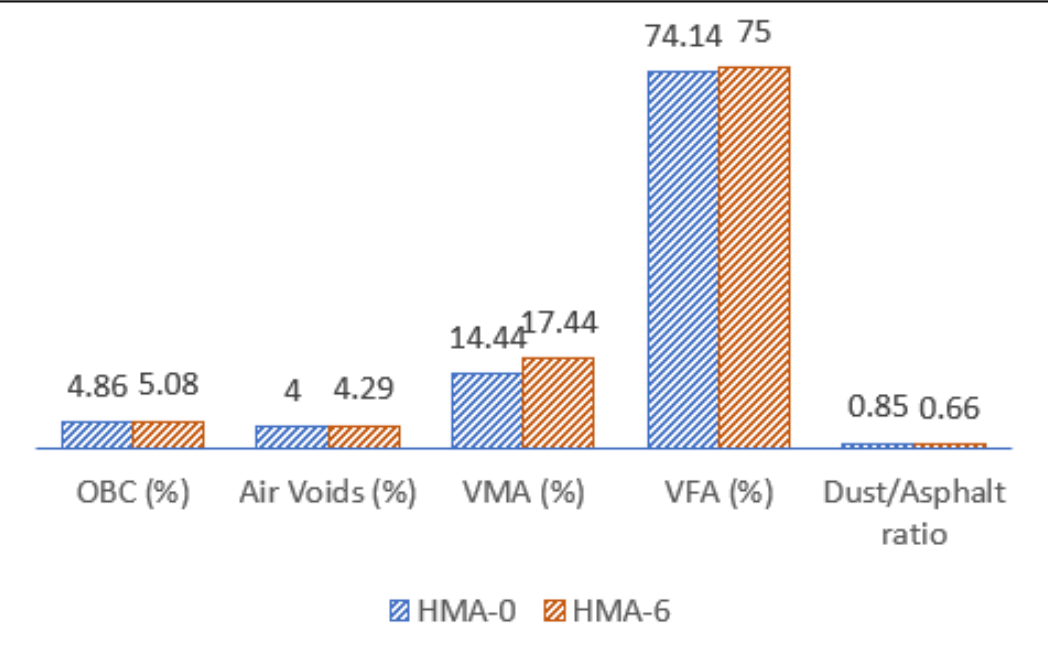
Figure 3. Volumetric properties of the mixes.